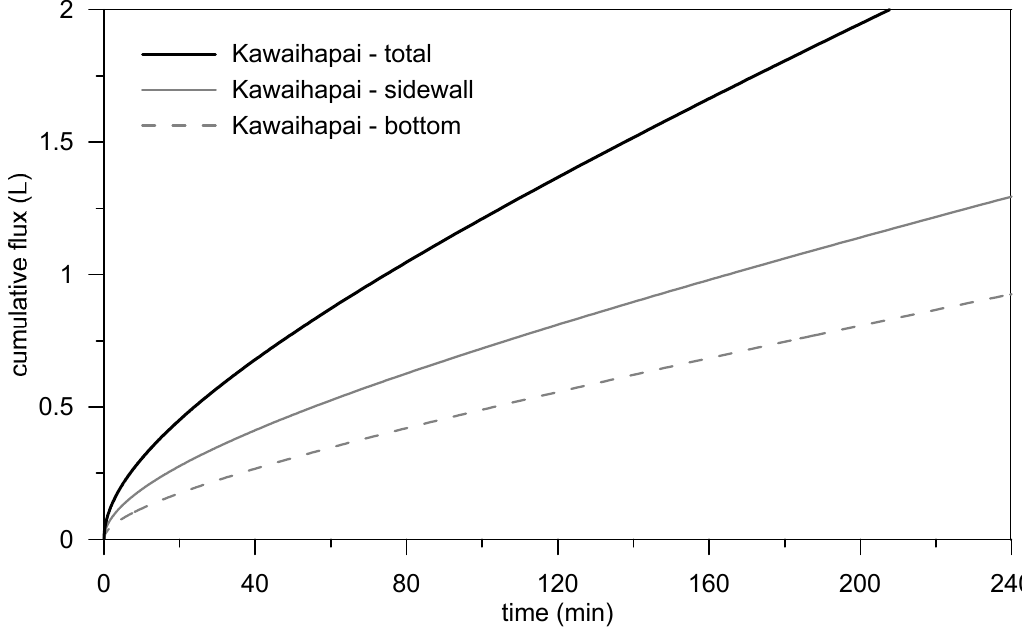
Figure 8. Cumulative flux through the sidewall and bottom of the trench for Kawaihapai soil.